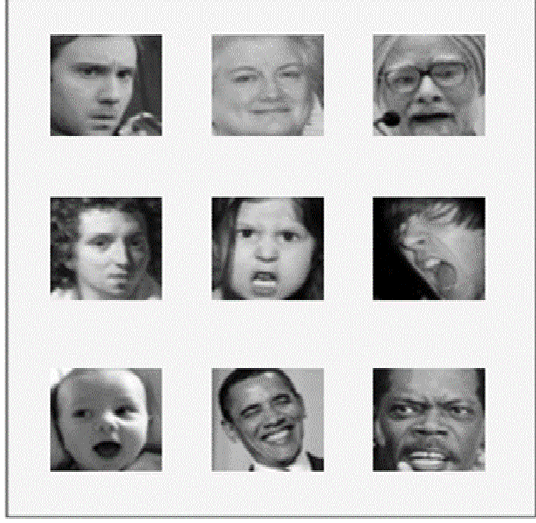
Figure 14. Samples in FER2013